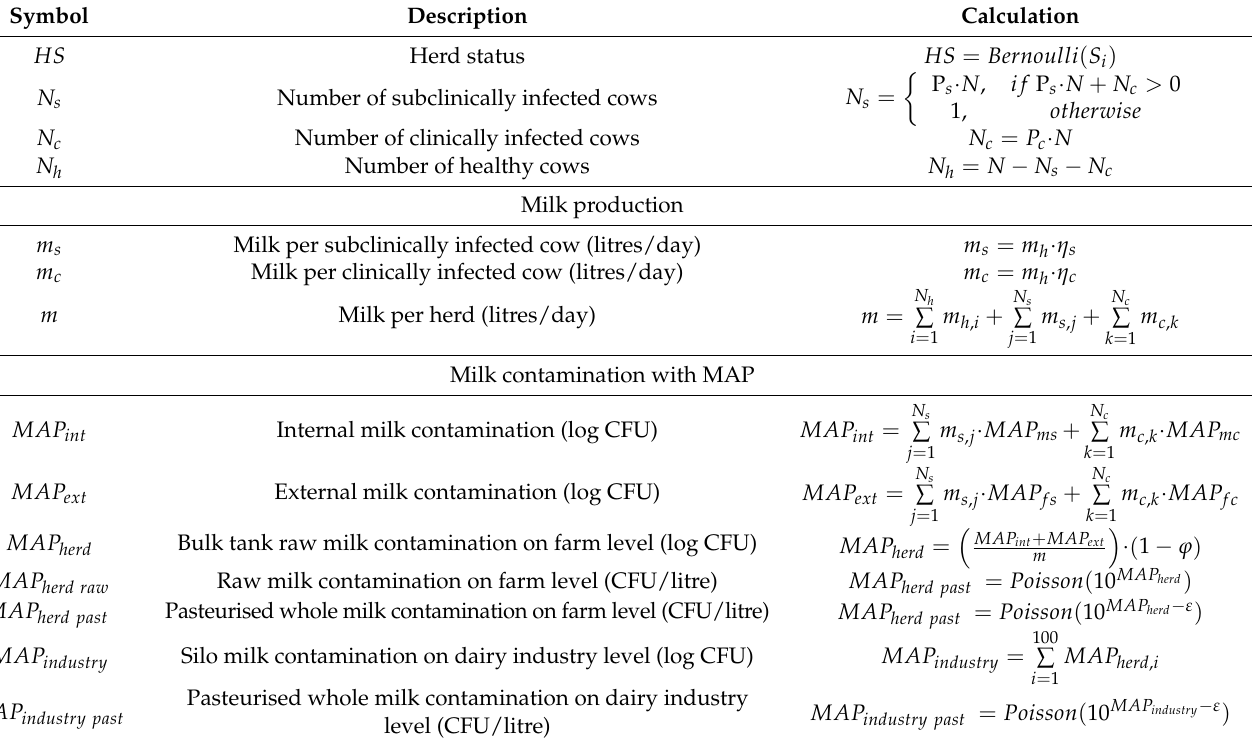
Table 2. Calculations used in the model to assess human exposure to Mycobacterium avium subsp. paratuberculosis (MAP) from different types of